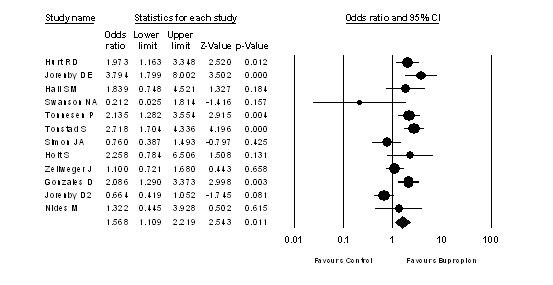
Random Effects Meta-Analysis. Bupropion vs. Controls at 12 months. I2 = 71.5%.